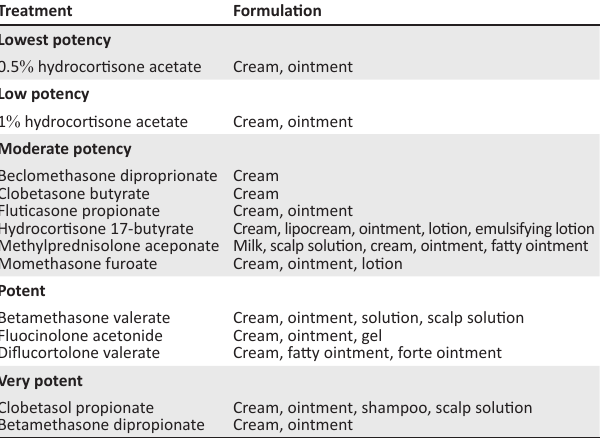
TABLE 2: Topical corticosteroids available in South Africa. 69